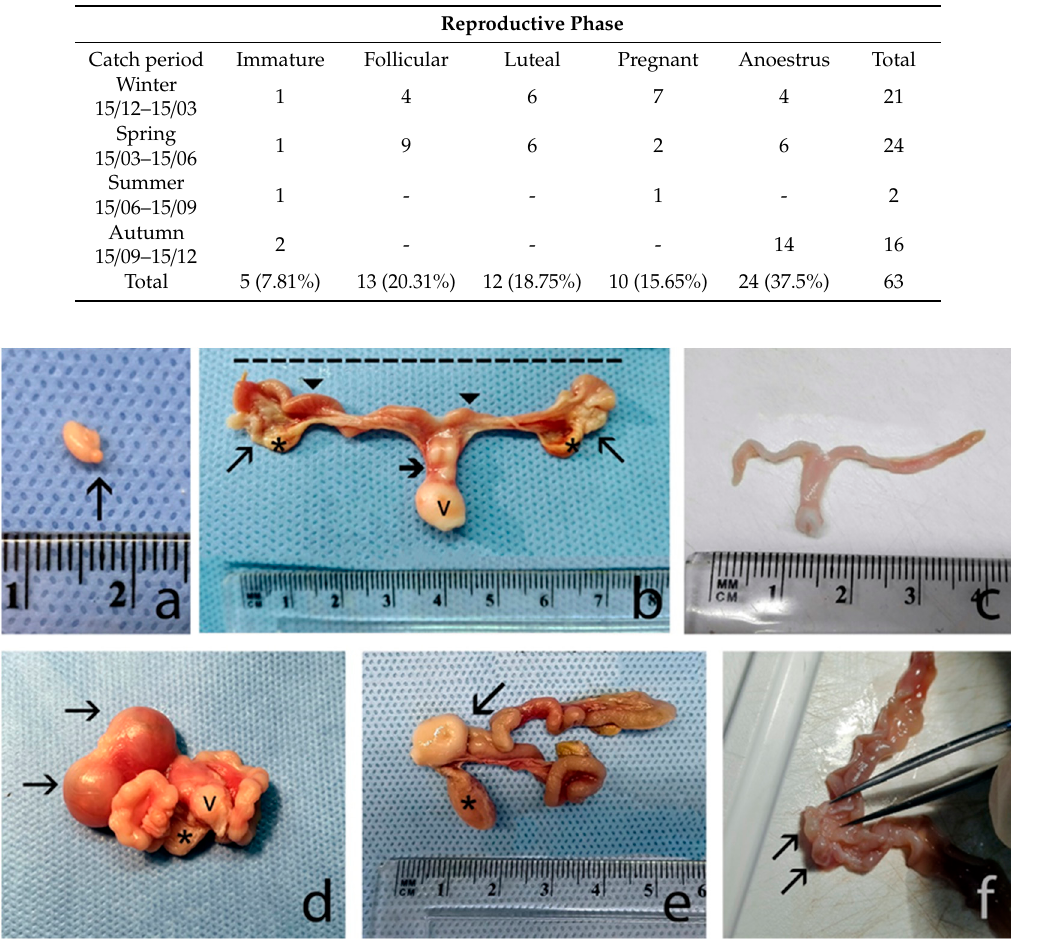
Figure 1. ( a ) An ovary with a corpus luteum (arrow) on the surface. ( b ) A reproductive apparatus, after cutting the broad ligament and stretching, composed of the ovaries and fallopian tubes (arrows), uterine horns (arrowhead), and vulva (v); two uterine horns placed side by side in their distal end (bold arrow). The broad ligament infiltrated by adipose bodies (*) can be observed. The dashed line indicates that the length of the uterus was measured between the two proximal ends. ( c ) A white, small, ribbon-like and quite relaxed uterus belonging to an immature squirrel. ( d ) Two embryonic vesicles (arrows) are contained within a uterus strongly folded back on itself and forming spiral loops. Bladder (*) and vulva (v) are shown. ( e ) Dorsal surface with a transverse groove (arrow) defining the border between the cervix and the vagina. The bladder (*) can be observed below the vagina. ( f ) Distal and medial portion of the two uterine horns opened to show longitudinal folds of the mucosa. The arrows indicate the two external orifices of the uterus.